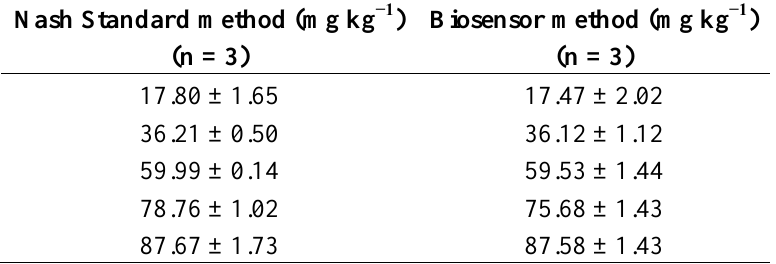
Table 7. Comparison between AOX-poly(nBA-NAS) microspheres based biosensor and Nash method in the determination of formaldehyde in shrimp sample.